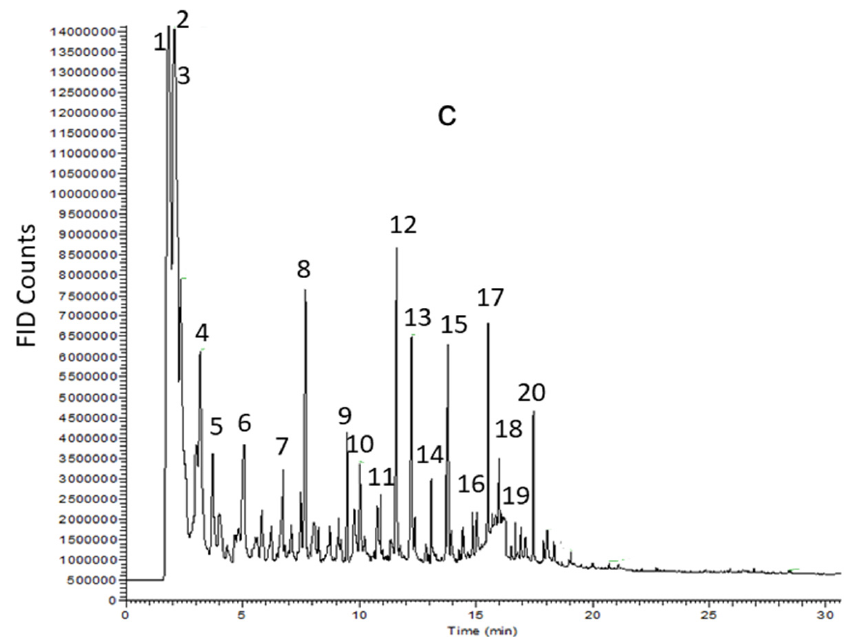
Figure 6. ( a ) Chromatogram of untreated PKS pyrolysis at 600 ◦ C at 5 s. The main components of the untreated PKS pyrolysis: (1) acetaldehyde; (2) acetic acid; (3) 2,3-pentanedione; (4) furfural; (5) phenol; (6) 4-hydroxy-5,6-dihydro-2H-pyran-2-one; (7) 2-methoxyphenol; (8) 4-methyl-2-methoxyphenol; (9) 1,2-benzenediol; (10) 4-ethyl-2-methoxyphenol; (11) 4-vinyl-2-methoxyphenol; (12) 4-(1- propenyl)-2-methoxyphenol; (13) 4-methoxy-3-(methoxymethyl)phenol; (14) 4-acetoxybenzoic acid; (15) 4-(2-propenyl)-2,6-dimethoxyphenol; (16) oleic acid. ( b , c ) Chromatogram of untreated MAH (b) and IRO (c) pyrolysis at 600 ◦ C at 5 s. The main components of the untreated MAH and IRO pyrolysis: (1) acetaldehyde; (2) hydroxyacetaldehyde (3) acetic acid; (4) 2,3-pentanedione; (5) furfural; (6) 2-methylcyclopentanone; (7) 4-hydroxy-5,6-dihydro-2H-pyran-2-one; (8) 2-methoxyphenol; (9) 4-methyl-2-methoxyphenol; (10) 3-methoxy-1,2-benzenediol; (11) 4-ethyl-2-methoxyphenol; (12) 4-vinyl-2-methoxyphenol; (13) 2,6-dimethoxyphenol (14) 4-(1-propenyl)-2-methoxyphenol; (15) 4-methoxy-3-(methoxymethyl)phenol; (16) 5-tert-butylpyrogallol; (17) 3-tert-butyl-4-hydroxyanisole; (18) levoglucosan; (19) 4-(2-propenyl)-2,6-dimethoxyphenol; (20) 4-(2-propenyl)-2,6-dimethoxyphenol- trans.